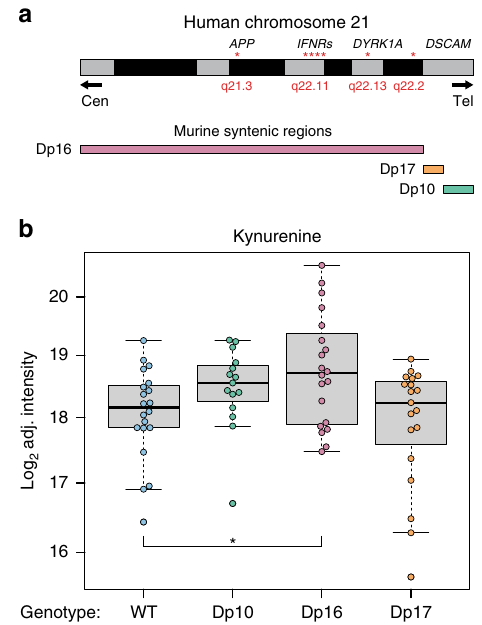
Fig. 4 Tryptophan catabolism is disrupted in the Dp16 model of DS. a Schematic of mouse models tested showing the localization key genes on chromosome 21, including four of the six IFN receptors in Dp16 mice ( Ifnar1 , Ifnar2 , Ifngr2 , and Il10rb ). b Box and whisker plots showing the relative quanti fi cation in log 2 adjusted intensity of plasma kynurenine in the indicated mouse model. p -values were calculated using a two-tailed Student ’ s t -test (* p < 0.05). Boxplot shows median, 25th, and 75th percentile values. Error bars are 1.5 times the interquartile range (IQR) or the maximum data point if <1.5 IQR. N ’ s for each strain were WT −